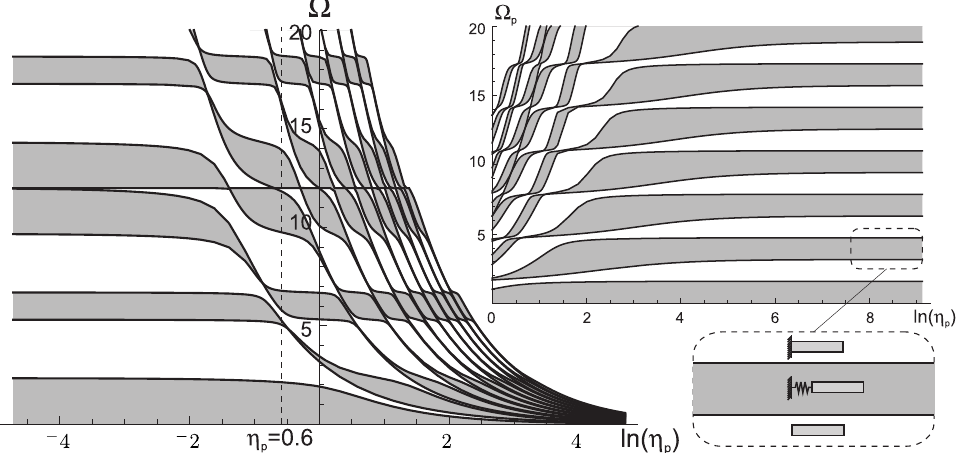
Figure 10. Continuous phase in parallel. Band distribution as a function of the characteristic frequency ratio η p . The distribution of the bands are given in term of the normalised frequencies Ω = ω / ¯ ω on the left and Ω p = ω / ω p on the right. Impedance and frequency ratios are: ξ c = 0.22, η c = 0.5 and ξ p = 1.20. The dashed line at η p = 0.6 indicates the configuration of Figure